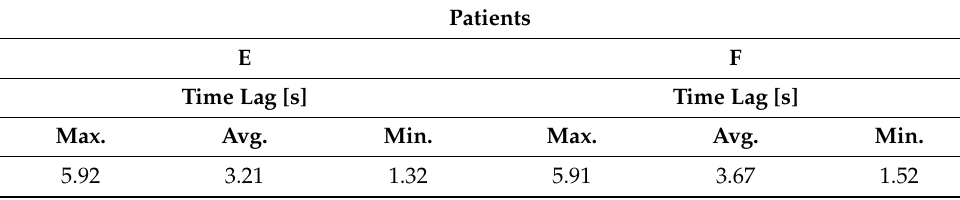
Table 7. Results of time lags in the principal indoor experiment.